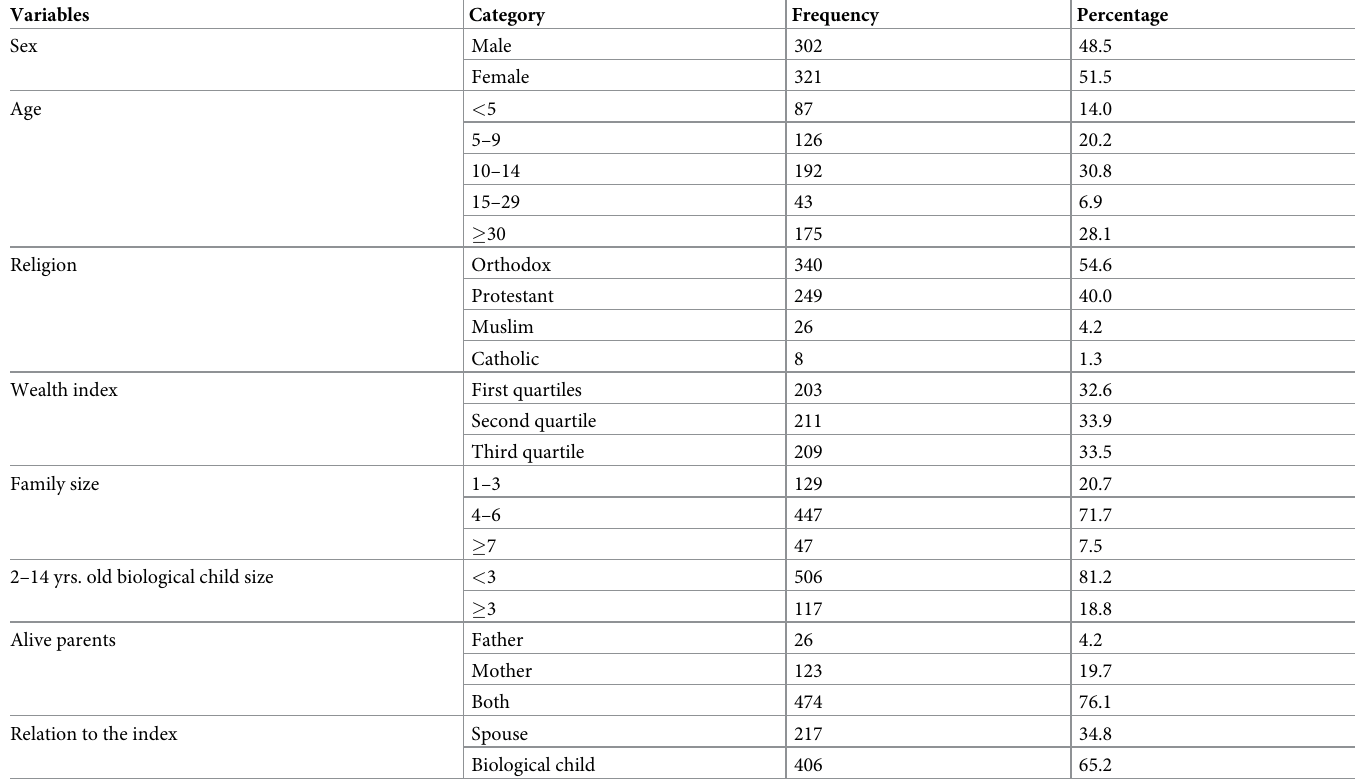
Table 1. Socio-demographic and economic characteristics of members of index cases in Sodo Town, Southern Ethiopia, 2021 (N =